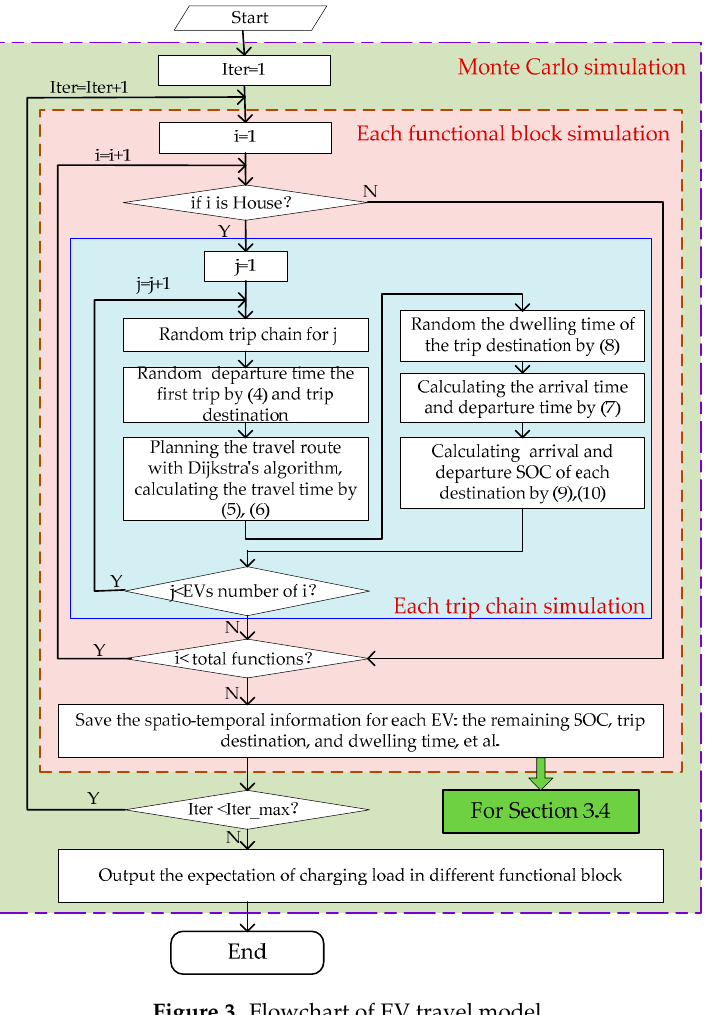
Figure 3. Flowchart of EV travel model.